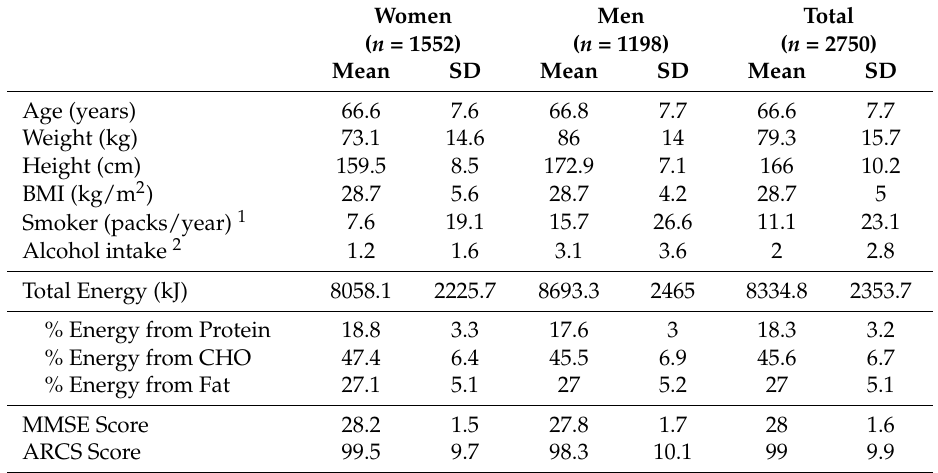
Table 1. Baseline characteristics for participants from the Hunter Community